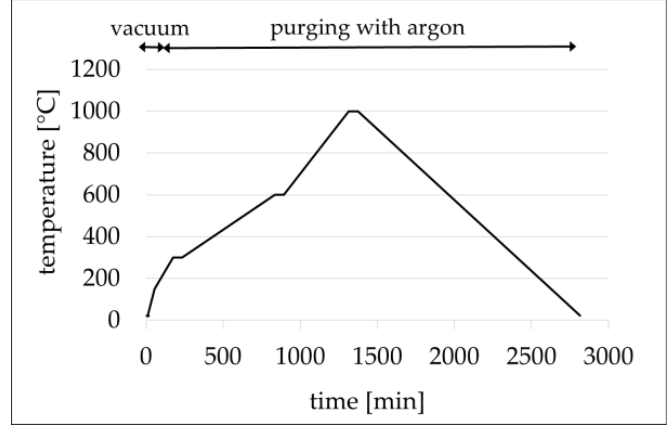
Figure 3. Temperature – time profile of the pyrolysis process.